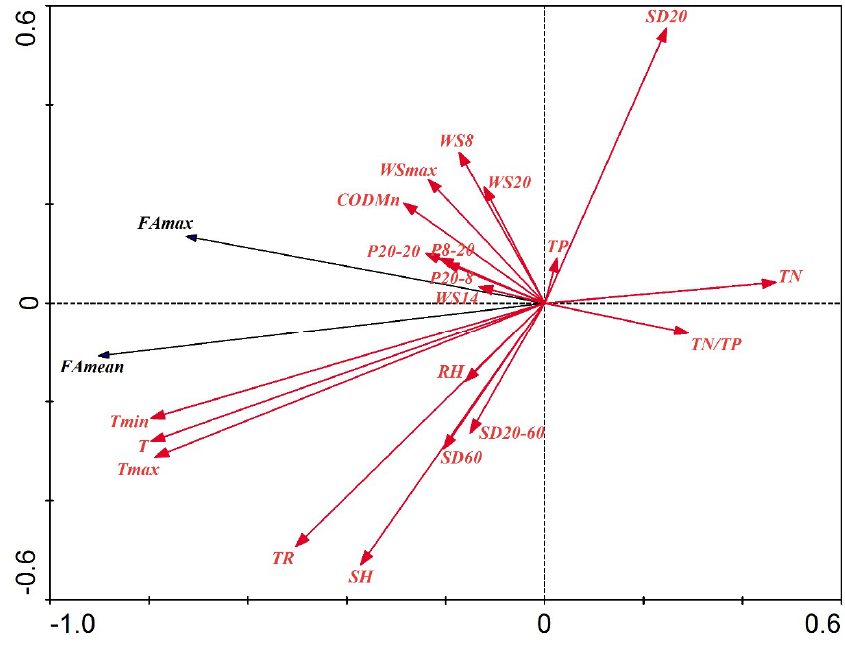
Figure 16. Redundancy analysis (RDA) ordination diagram of monthly cyanobacteria bloom characteristics and environmental variables.